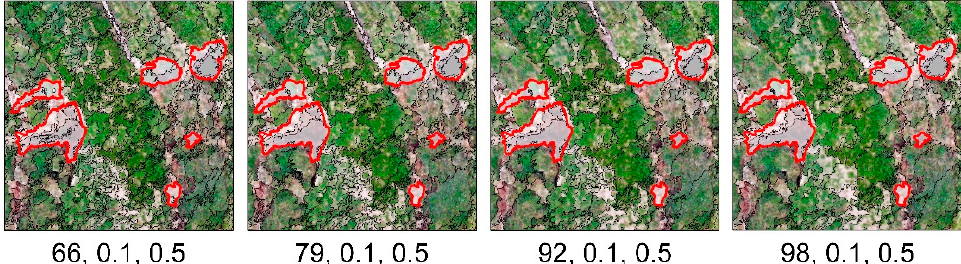
Figure 5. Segmentation results with different candidate scale parameters. The three values under each figure represent the scale, shape, and compactness, respectively. The actual terrace damage areas are highlighted by red lines.